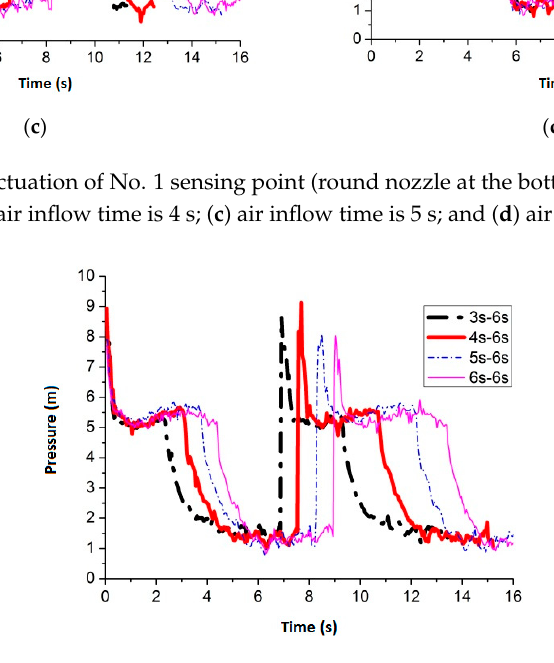
Figure 10. The four best pressure values (round nozzle at the bottom of the pipe).